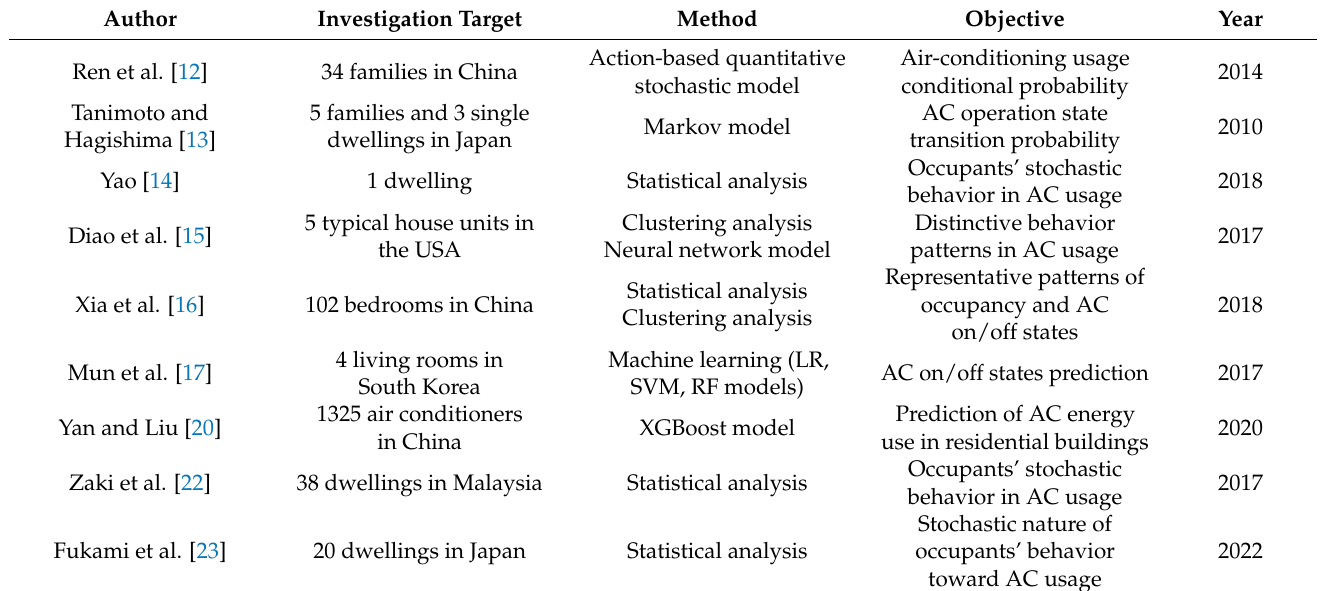
Table 1. Summary of previous studies of OB in residential AC usage.